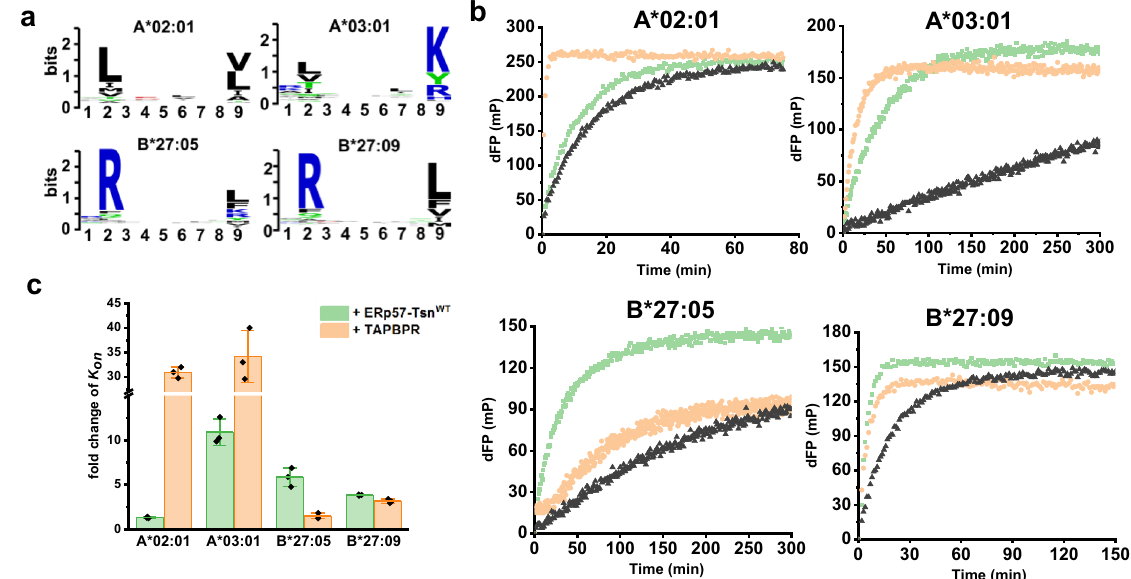
Fig. 2 The susceptibility of MHC-I allotypes to tapasin-mediated peptide exchange is different. a Sequence logo of peptide that binds to A*02:01, A*03:01, B*27:05, and B*27:09. Peptides known to bind to these alleles were downloaded from IEDB and sequence logos were generated in https:// weblogo.berkeley.edu. b Representative peptide exchange pro fi les of 500 nM A*02:01/photoKV9, A*03:01/photoKK9, B*27:05/photoRL9, B*27:09/ photoRL9 in the absence (black) and presence of equimolar amounts of ERp57-Tsn WT (light green) or TAPBPR (wheat) after UV exposure. Peptide exchange was monitored after adding the FITC-version of the peptide used in refolding for each allotype (FITC-GV9 for A*02:01, FITC-KK9 for A*03:01 and FITC-RL9 for B*27:09/05). The measuring time was different for each allotype. dFP means the baseline was subtracted. c The fold changes of observed association rate K on in the presence of ERp57-Tsn WT or TAPPBR for four allotypes. Error bars (standard deviation, SD) were calculated from three independent Fig. 5). Since the peptide exchange of A * 02:01/photoKV9 was only slightly enhanced by tapasin, we focused on A * 03:01, B * 27:05, and B * 27:09 allotypes and investigated the catalytic activity of the mutants ERp57-Tsn L18G , ERp57-Tsn K16G and ERp57-Tsn GGGGG on peptide exchange. The relative catalytic activity of the mutants compared to the wild type were calculated by the formula ((K on_Tsn_mutant – K on_Tsn - )/(K on_Tsn_WT – K on_ Tsn - ) for each allotype.